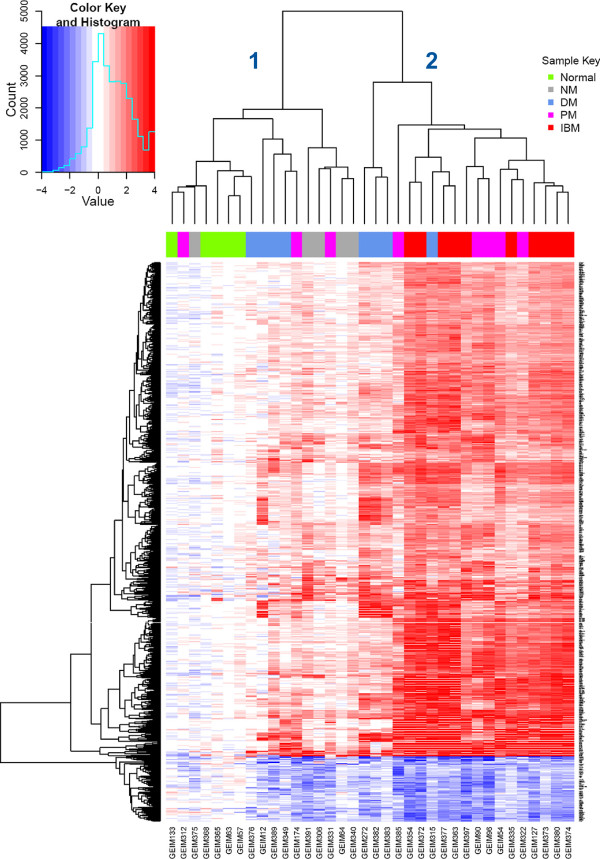
Heatmap of 837 differentially expressed transcripts. Transcript expression fold change is represented by the color scale increasing from blue to white to red; the color key is shown in the top left corner. The 36 subjects are shown horizontally and represented by the color bar on the top of the heatmap. The color that corresponds to each disease type is displayed in the upper right corner. At the first bifurcation of the horizontal dendrogram, the subjects are classified into 2 groups from left to right: group 1 and group 2.